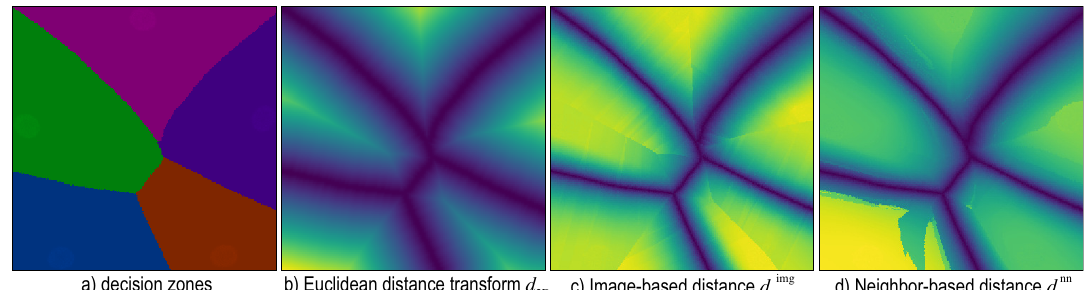
Figure 8. Dense map ( a ) and various distance-to-boundary maps ( b – d ) for Blobs dataset, computed using UMAP for P and NNInv for P − 1 .